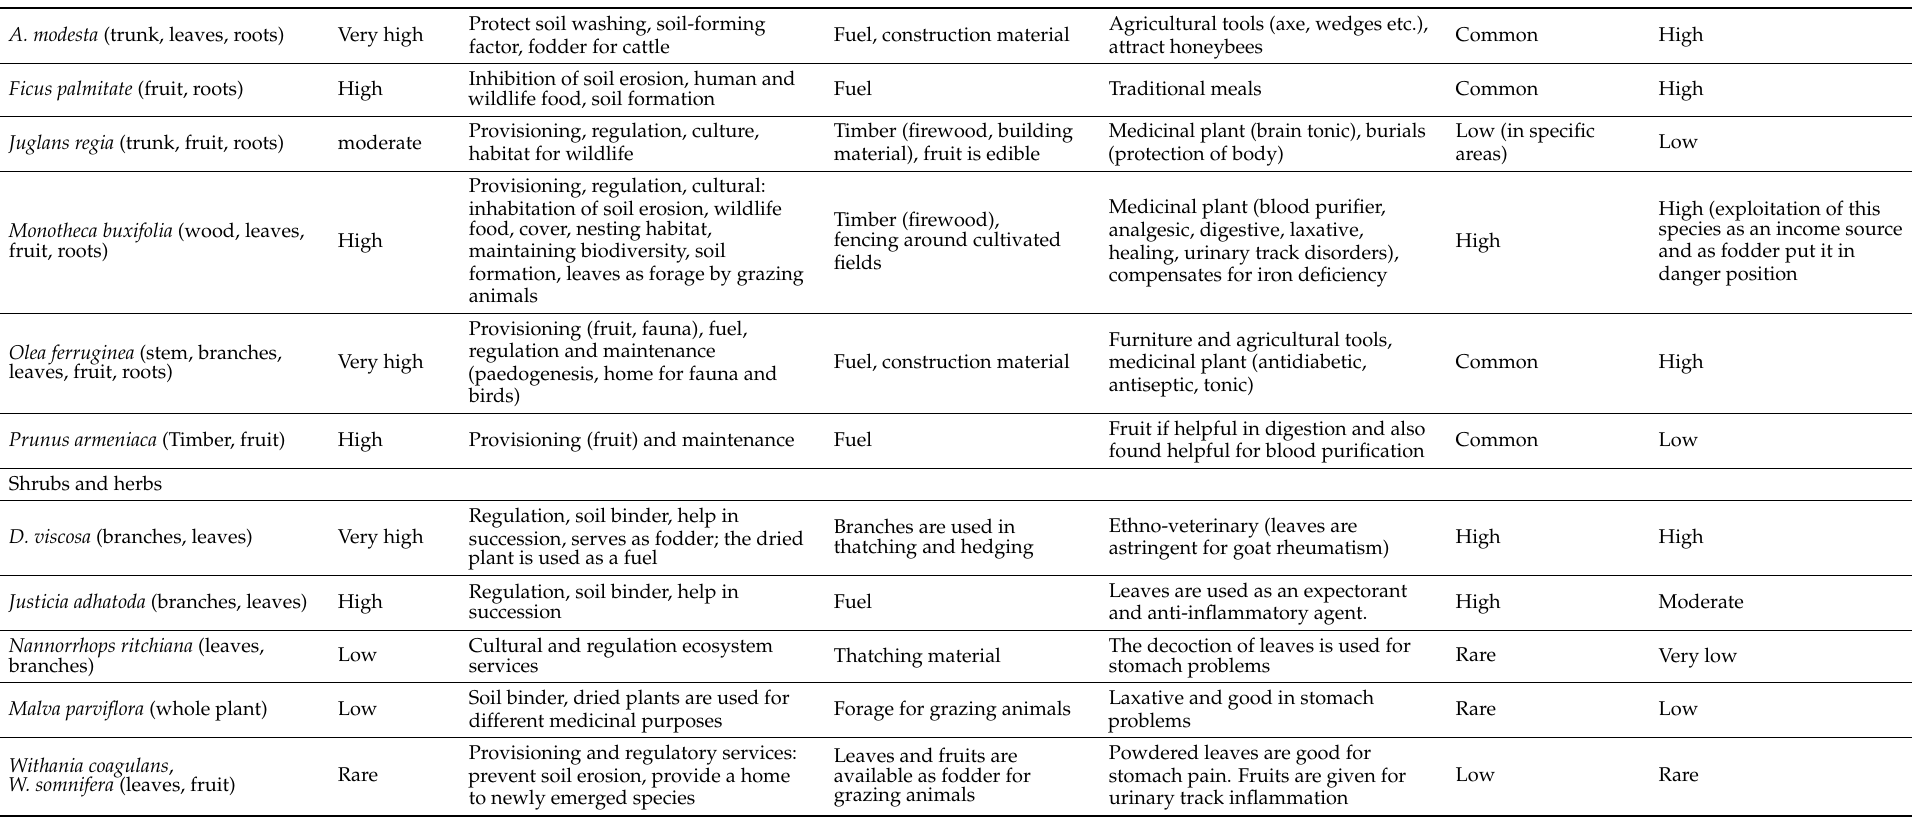
Table 4. Cultural keystone species and their potential for providing ecosystem services to the mountain